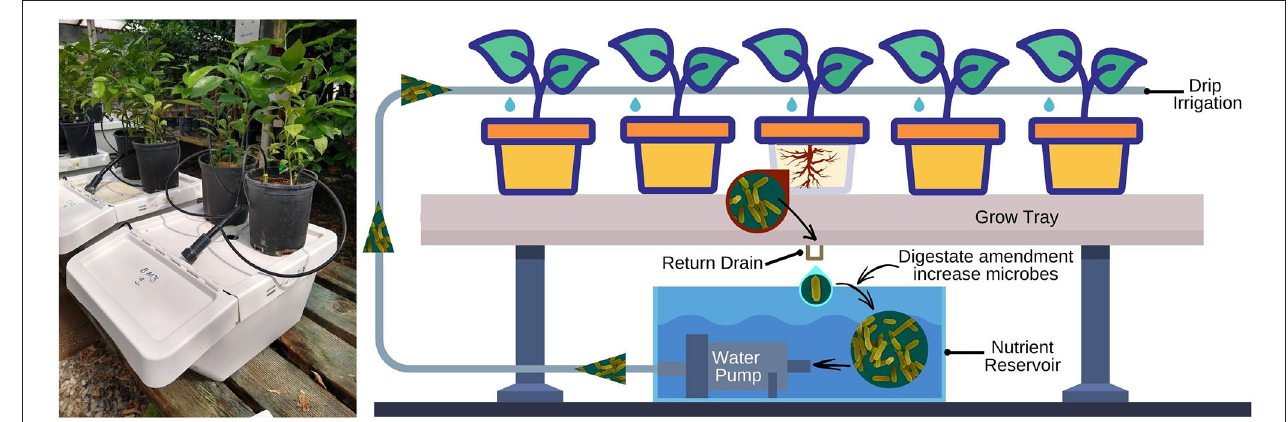
FIGURE 1 | On the left, citrus seedlings in drip-irrigated hydroponic units in a temperature-controlled greenhouse. On the right, simplified layout of a recirculating hydroponic system. FW and BM digestates, at 4 ml/L of nutrient solution, were amended to the reservoir at 7 days